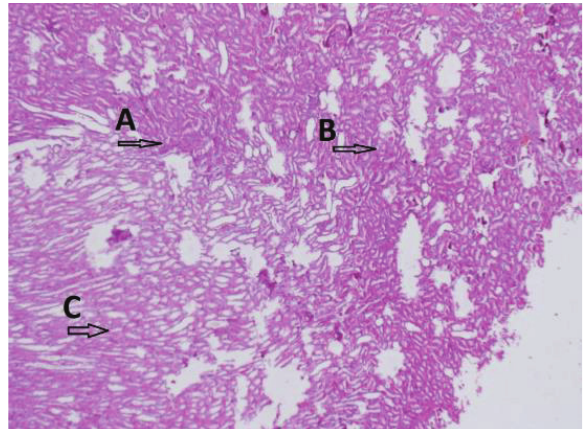
Fig-1 : Histopathology of normal kidney(rat)under 4x A. Intact cortex and medulla B. Tubules with normal